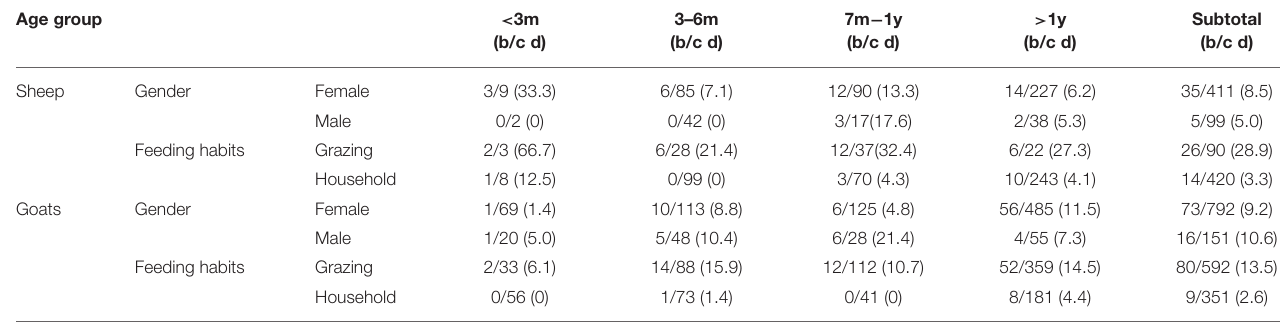
TABLE 3 | Prevalence distribution of A. capra by age, gender, and feeding habits in sheep and goats from China 2012–2017. Age group